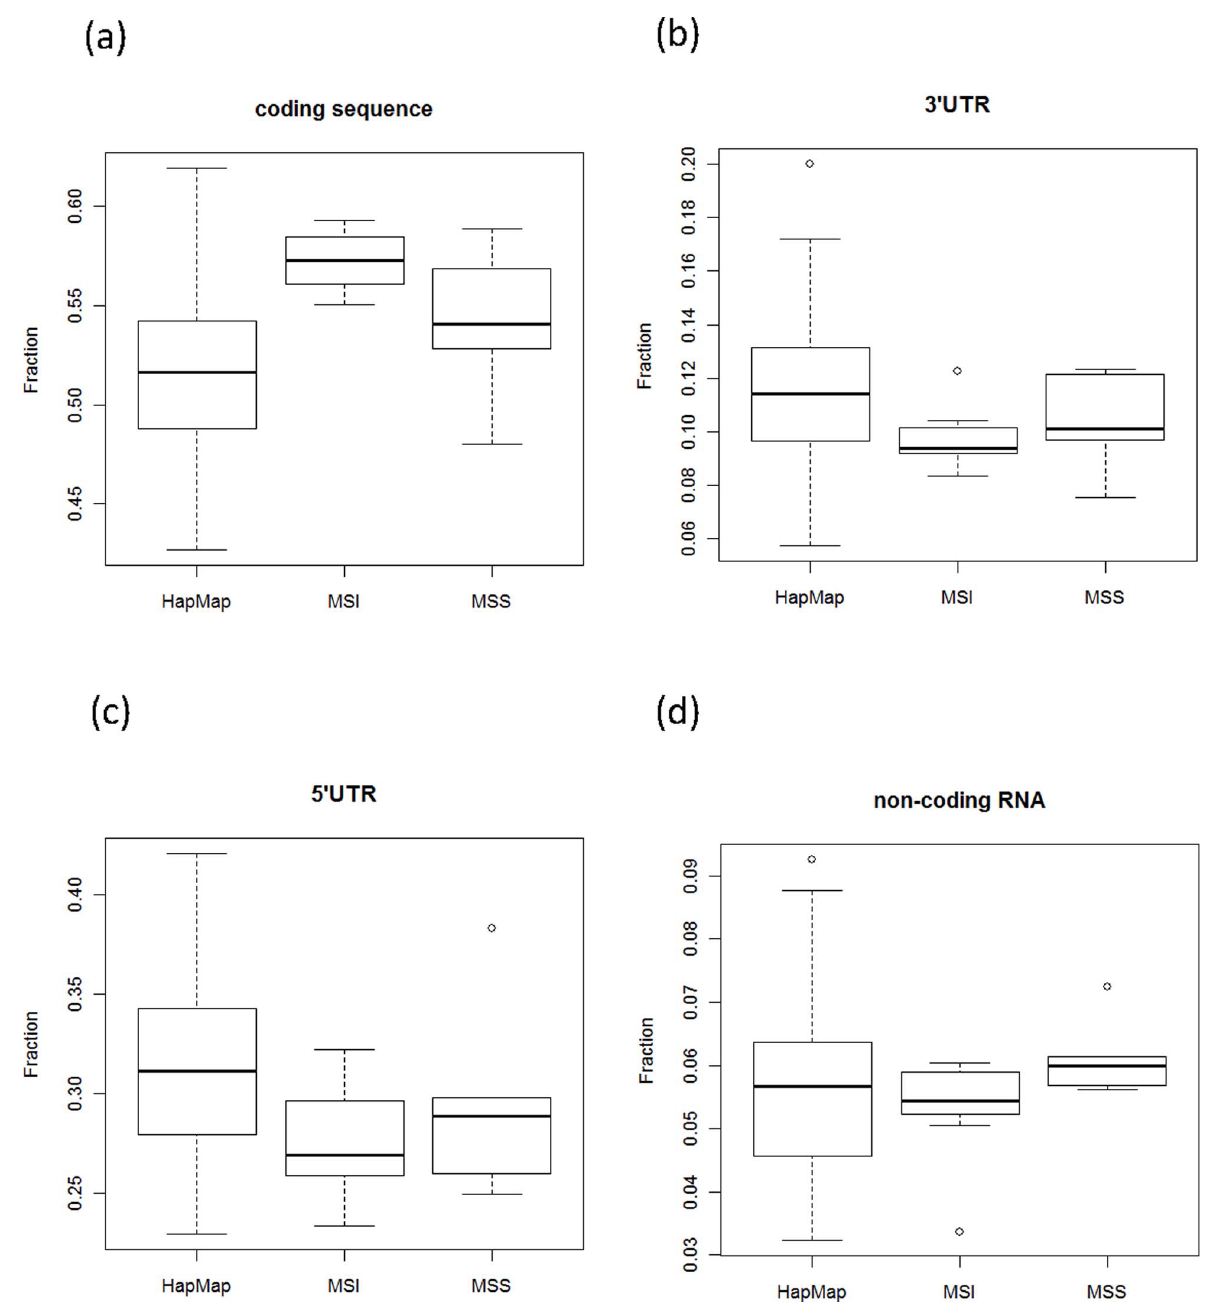
Figure 3. Proportions of microsatellite indels in different regions of transcripts. (a) Coding sequences (b) 3 9 UTR (c) 5 9 UTR (d) Non-coding RNA.